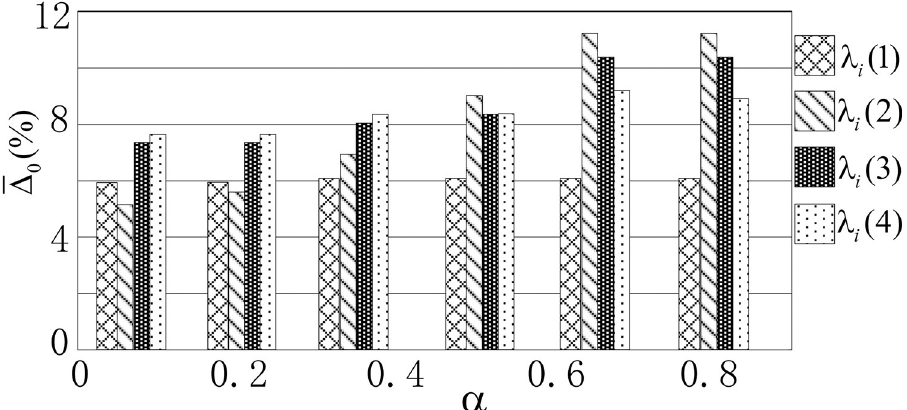
Fig 7. Curve relationship with normalized average error and different